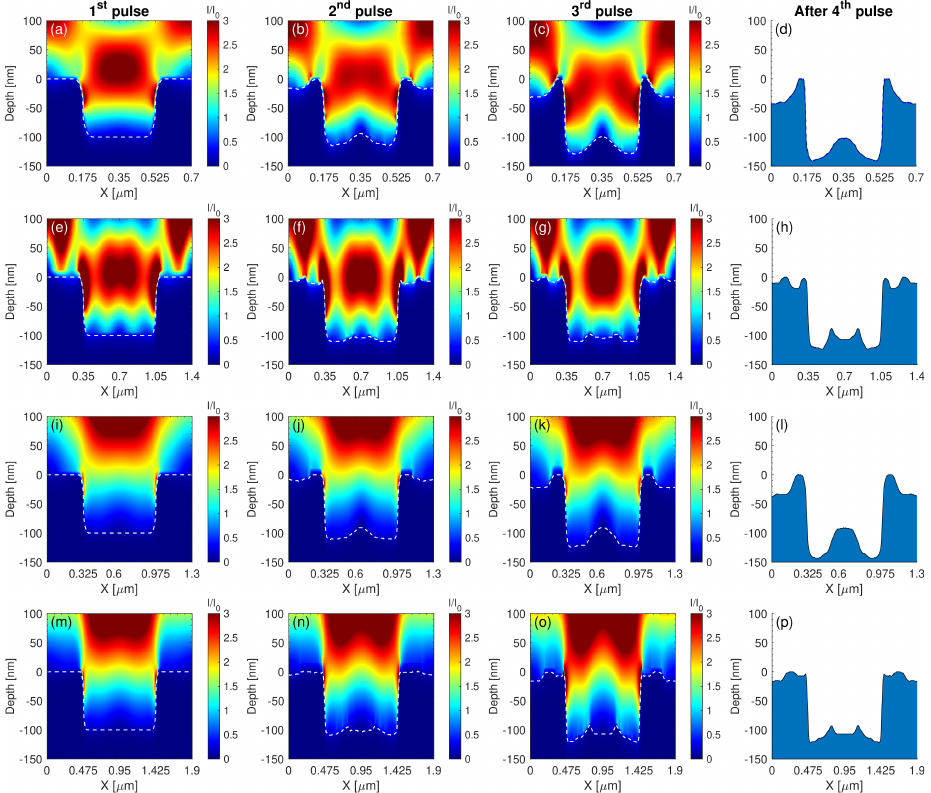
Figure 6. Spatial profile of the intensity distribution for different pre-pattern distances Λ pre − pattern and laser wavelengths λ on the x-z plane. In these images the pre-pattern topography evolution upon successive irradiation is also captured ( white dashed lines). The first, second and third column represent the intensity distribution during the first, second and third laser pulse, respectively, while the final LIPSS topography after four pulses is depicted in the fourth column (side view of the mor- phology). ( a – d ) λ = 513 nm for Λ pre − pattern = 700 nm, ( e – h ) λ = 513 nm for Λ pre − pattern = 1400 nm, ( i – l ) λ = 1026 nm for Λ pre − pattern = 1300 nm and ( m – p ) λ = 1026 nm for Λ pre − pattern = 1900 nm. The white dashed line indicates the surface